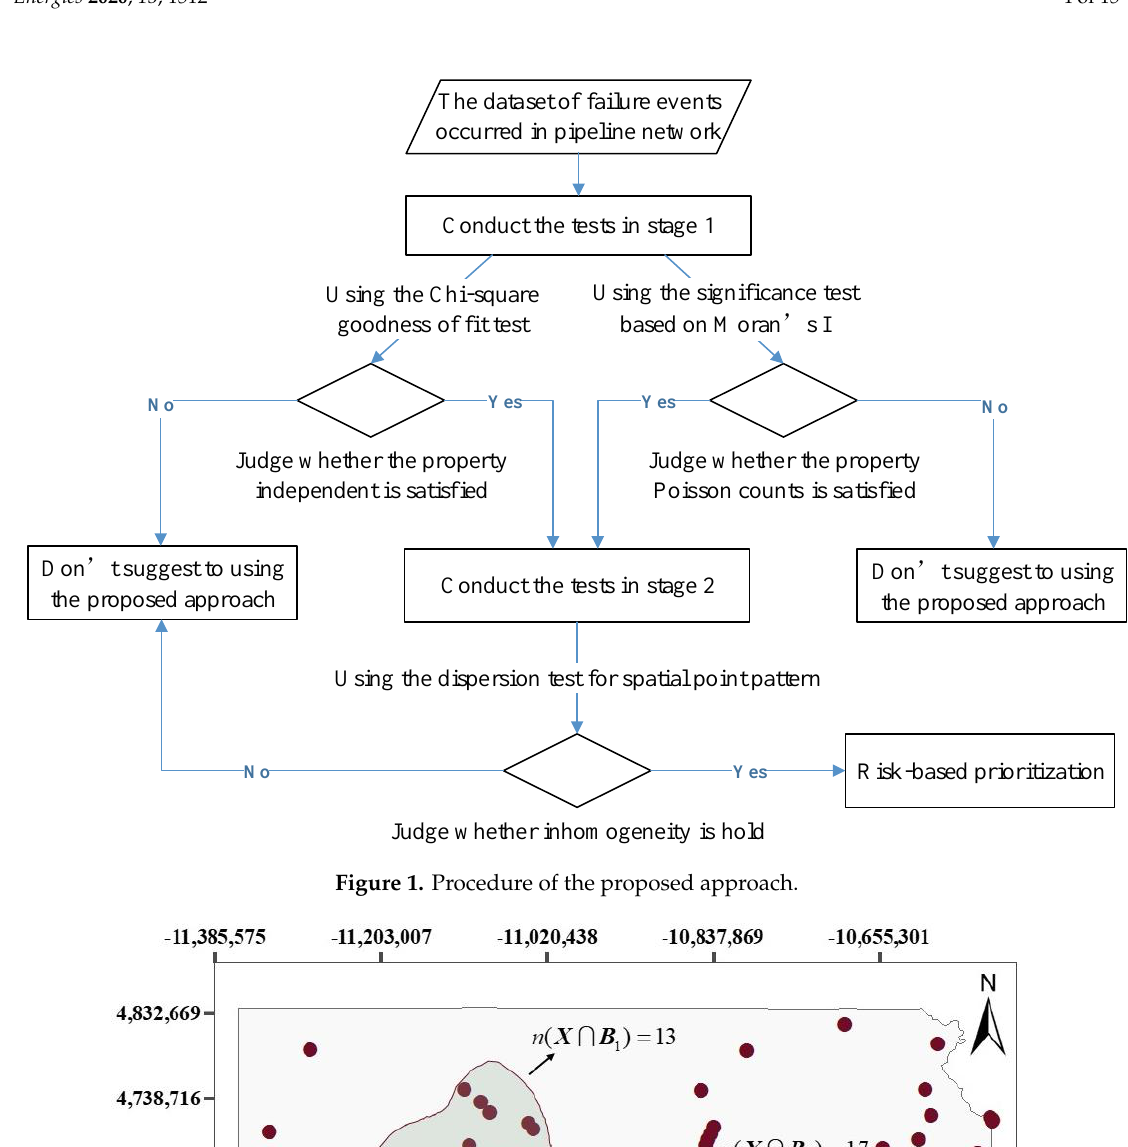
Figure 1. Procedure of the proposed approach.